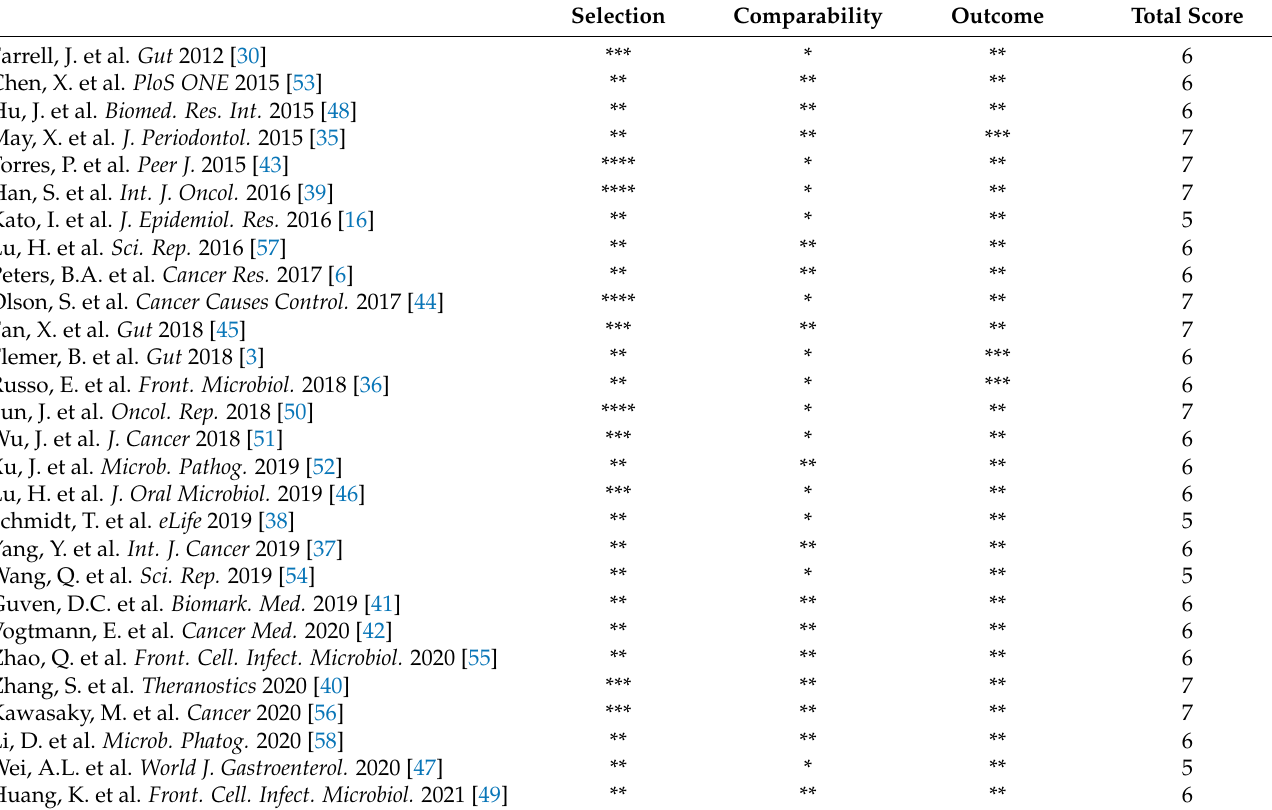
Table 3. Quality assessment of the selected studies according to the star score of the Newcastle–Ottawa Scale, NOS, based on which * are assigned to three criteria, i.e., selection (with a maximum of 4 stars [****]), comparability (with a maximum of 2 stars [**]), and outcome (with a maximum of 3 stars [***]) for a maximum of 9 stars. Higher scores indicate lower risk of